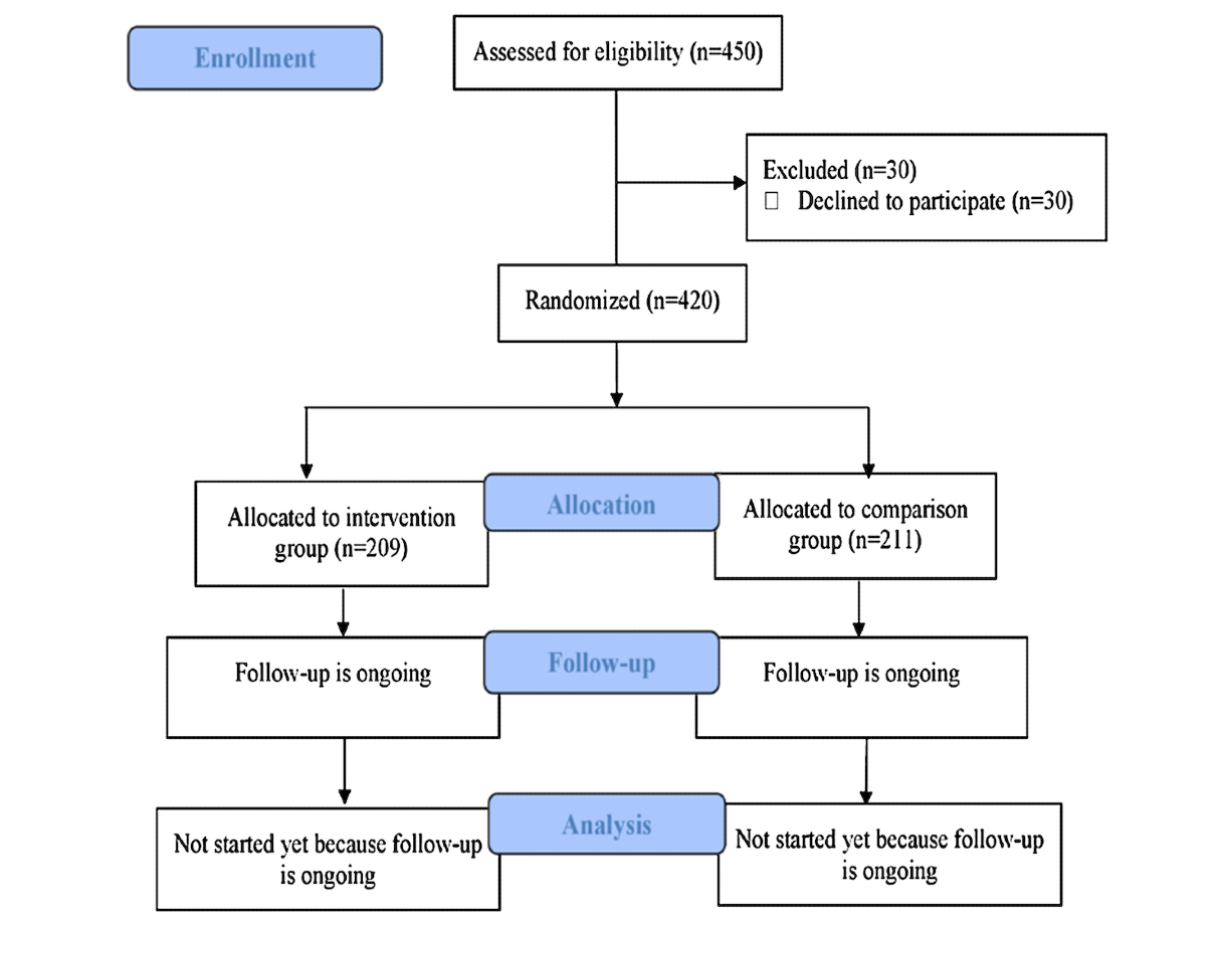
Figure 2. Enrollment procedure of the study.